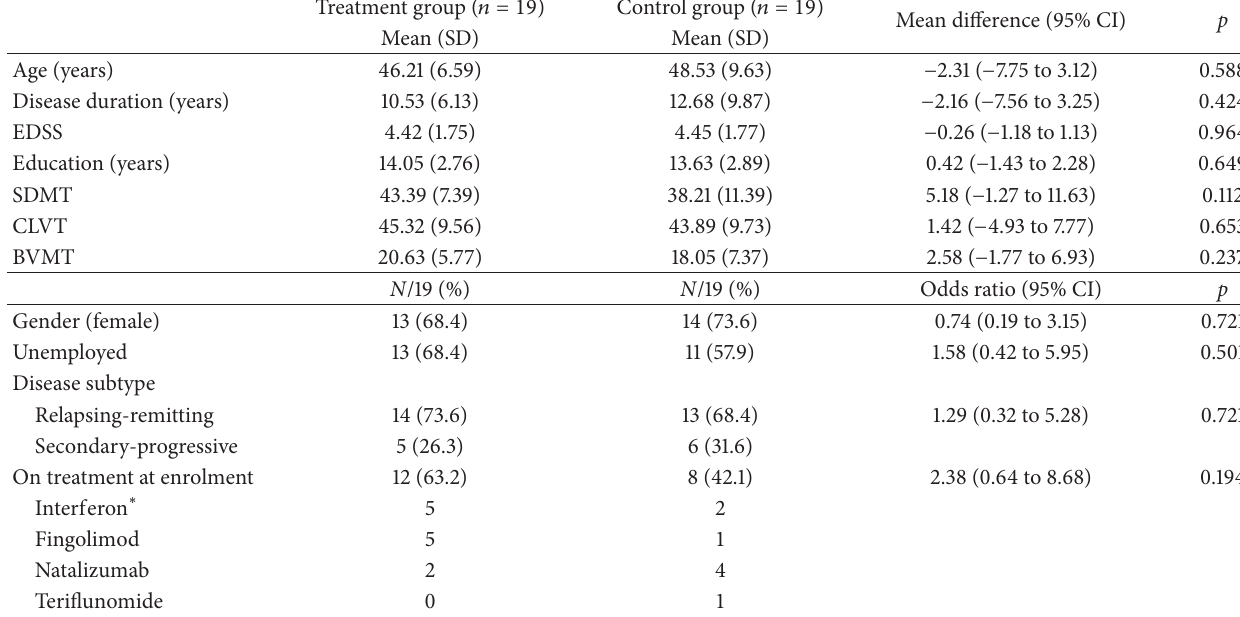
Table 1: Baseline demographic characteristics and cognitive performance.